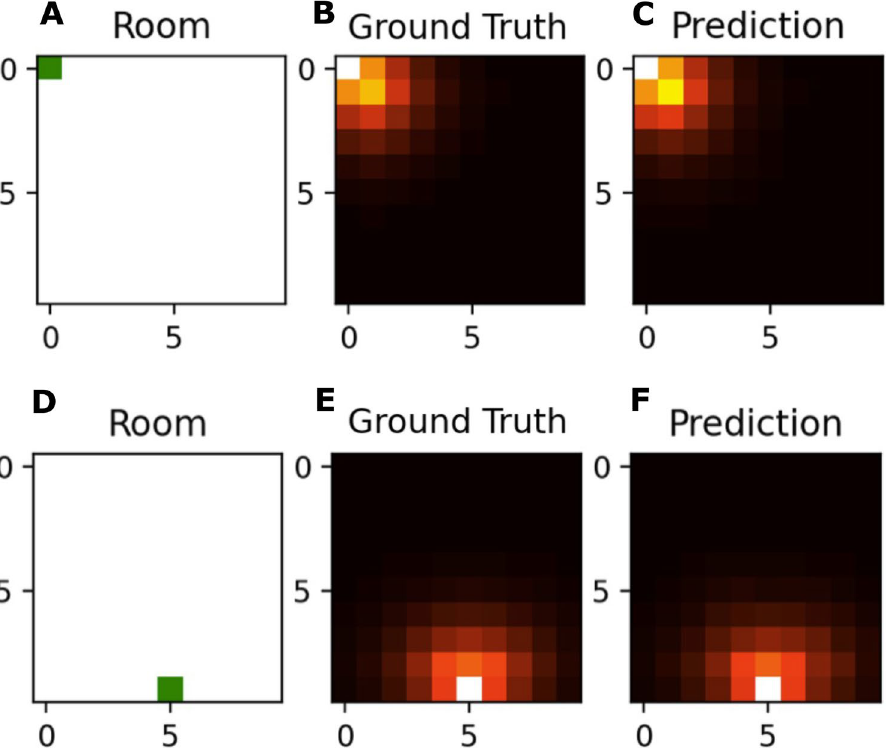
Figure 3. Supervised learning to explore a spatial environment: The SR for a 2D squared environment is learned with a supervised neural network. The small green squares indicate two sample starting positions ( A , D ). The corresponding SR are calculated and serve as ground truth ( B , E ). The neural network learns the transition probabilities for its direct neighbors and estimates the SR for a sequence length of t = 10 ( C , F